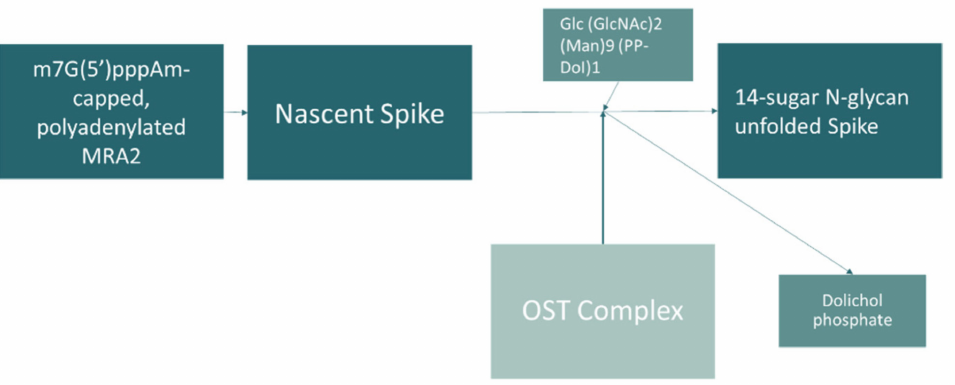
Figure 3. Pathway of spike protein glycosylation, according to Reactome.org [28]. DDOST gene relation with SARS-CoV-2 infection: maturation of SARS-CoV-2 spike protein by N-glycosylation involving the oligosaccharyltransferase (OST) complex. Mammalian cells express OST complexes that contain a catalytic subunit and accessory proteins as the dolichyl-diphosphooligosaccharide–protein glycosyltransferase 48 kDa subunit (DDOST). DDOST catalyzes the initial transfer of a glycan from the lipid carrier dolichol-pyrophosphate to the nascent polypeptide chain. Image adapted from reactome.org (accessed on 22 February